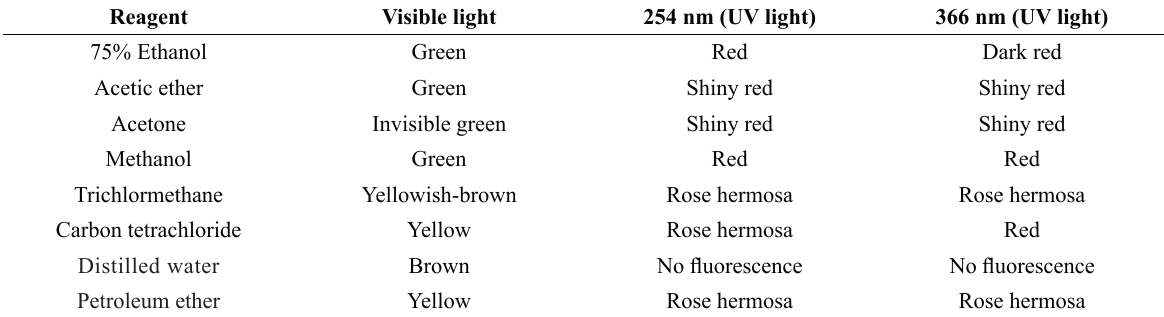
Fluorescence characteristics of Desmodium caudatum .